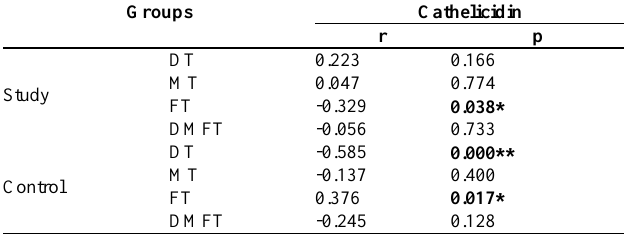
Table 5 : Correlation coefficients between dental caries experience (DMFT index) and salivary cathelicidin in the study and control